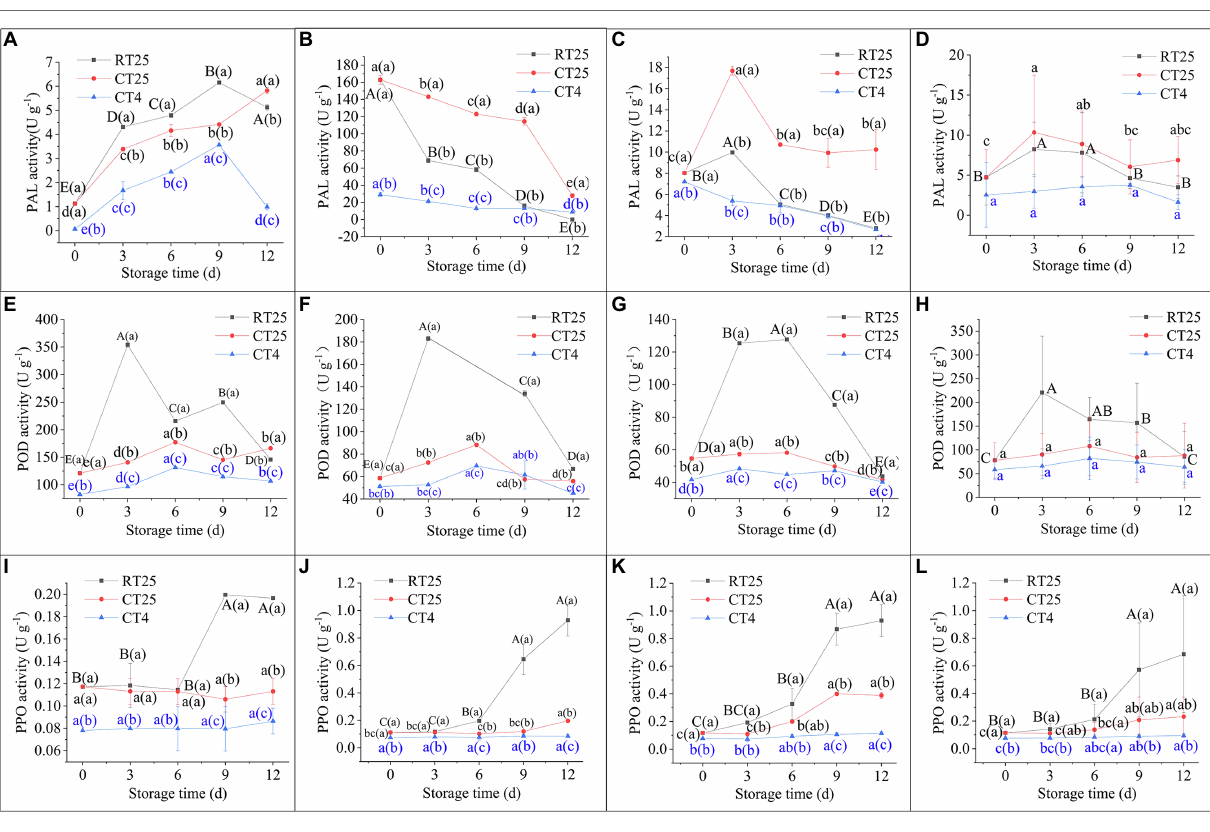
FIGURE 10 | Dynamic changes in phenylalanine ammonia lyase (PAL), Peroxidase (POD), and Polyphenol oxidase (PPO) activities in bamboo shoots during storage at 25 ° C and 4 ° C. RT25, bamboo shoots stored at room temperature and analyzed at 25 ° C; CT25, bamboo shoots stored at cold temperatures and analyzed at 25 ° C; and CT4, bamboo shoots stored at cold temperatures and analyzed at 4 ° C. (A–D) PAL activity in shoots during storage for upper (A) , middle (B) , and bottom (C) plant parts, and mean values (D) . (E–H) POD activity in shoots during storage from upper (E) , middle (F) , and bottom (G) plant parts, and mean values (H) . (I–L) PPO activity in shoots during storage for upper (I) , middle (J) , and bottom (K) plant parts, and mean values (L)